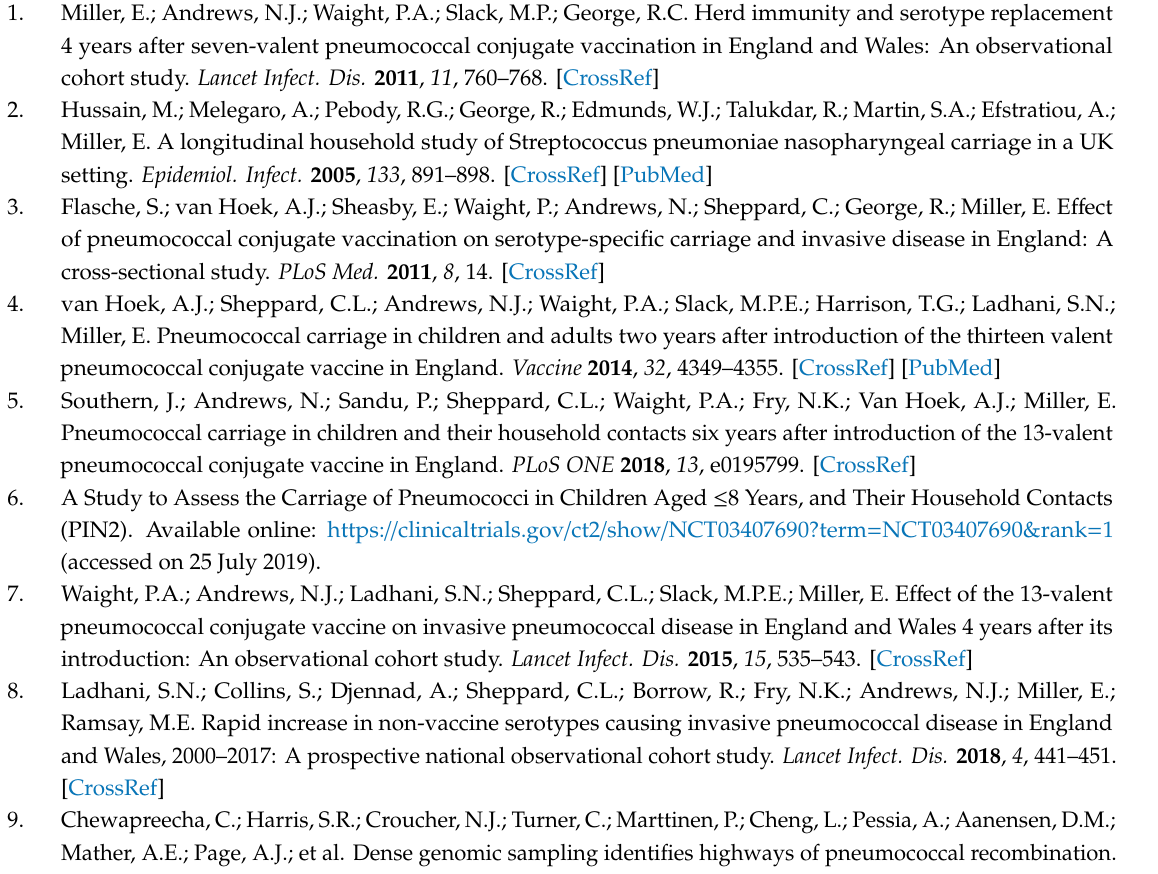
Table S1: ENA Submission details, Table S2: Serotype discrepancies, Table S3: GPSC with multiple local clusters, Table S4: Abricate results, Table S5: Roary